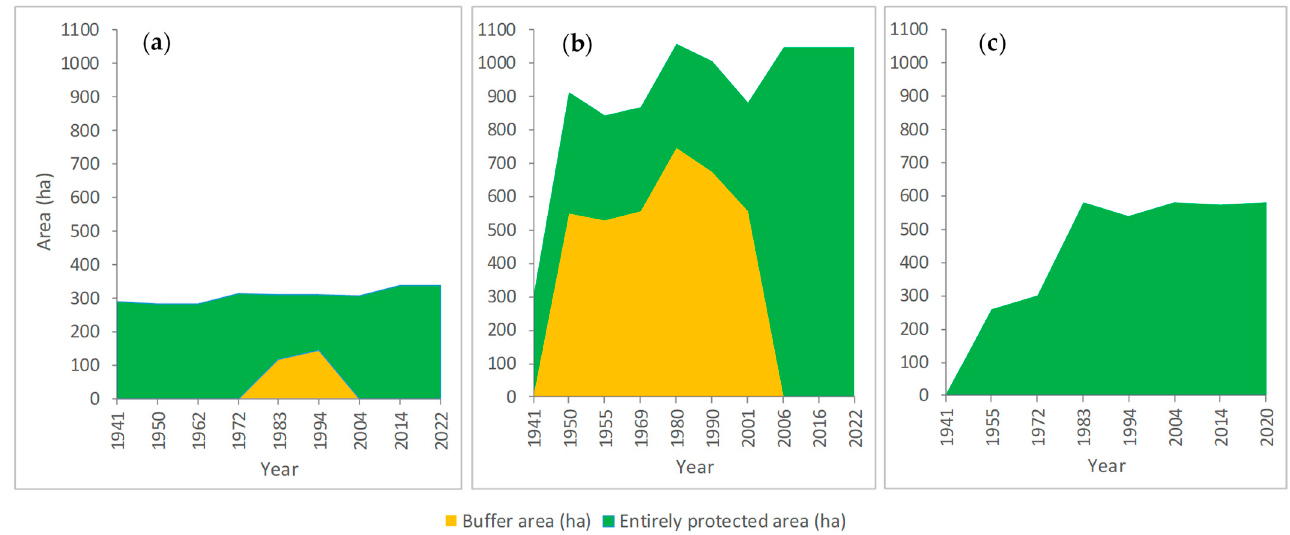
Figure 2. Dynamic of forest areas set aside since 1940 in N2000-RG: ( a ) Codrul secular Giumal ă u; ( b ) Codrul secular Sl ă tioara; ( c ) Rar ă u—Pietrele Doamnei Nature reserve. ( b ) Codrul secular Sl ă tioara; ( c ) Rar ă u—Pietrele Doamnei Nature